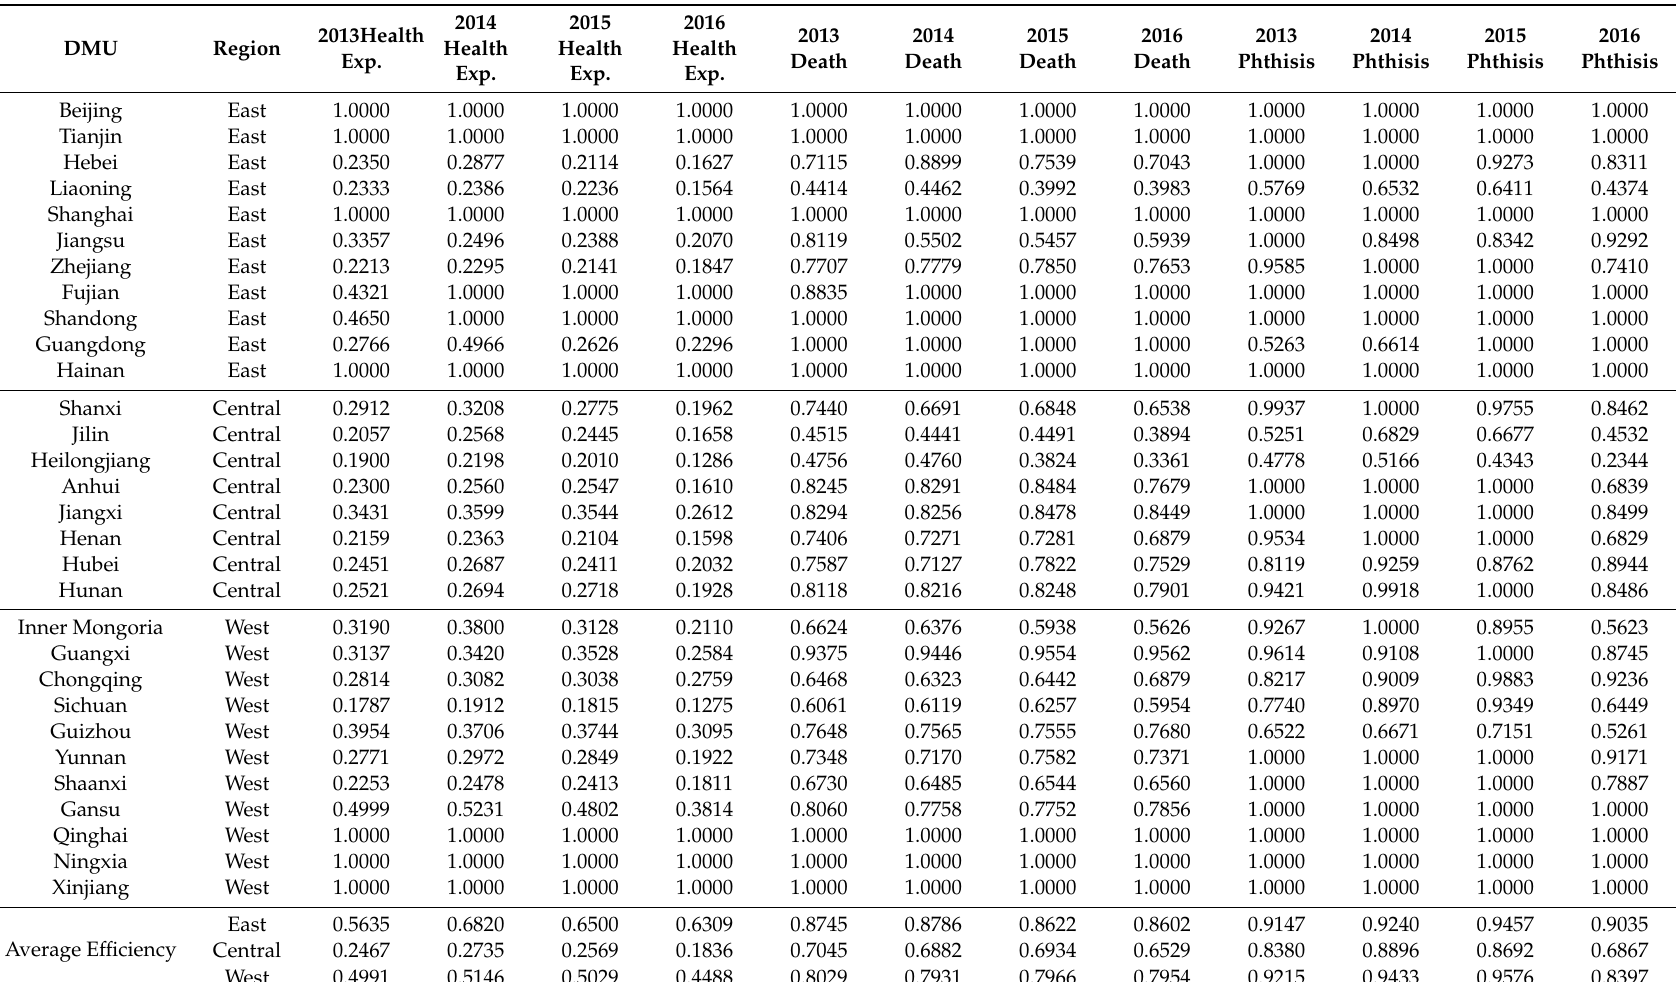
Table 8. Health expenditure, death rate, and phthisis e ffi